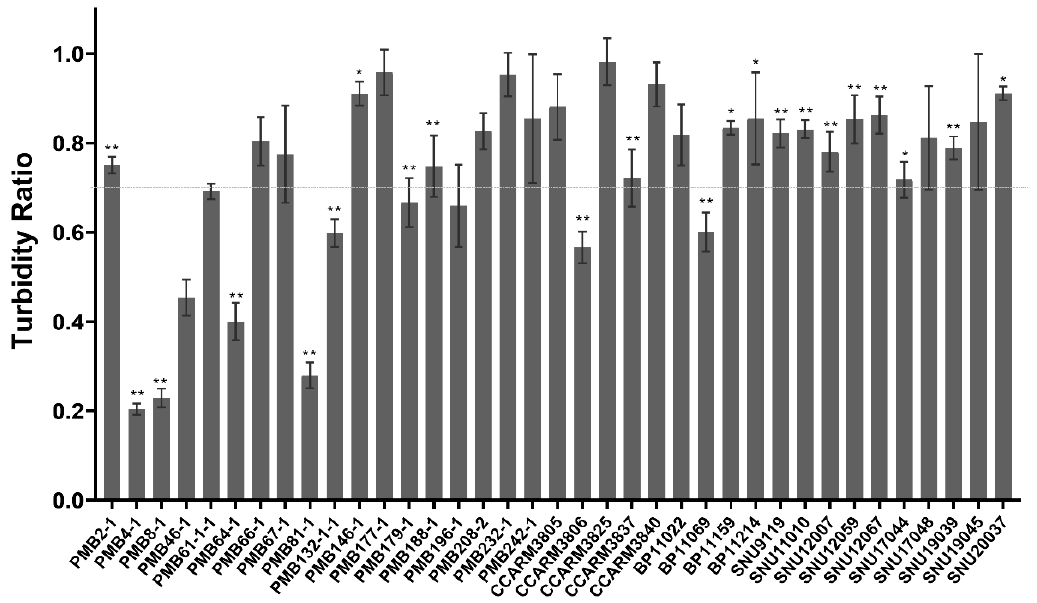
Figure 3. Different susceptibility of S. aureus strains to ALS2. After 6 h incubation of bacteria and ALS2, the turbidity ratio (TR) for each strain was determined by calculating the OD 600 value ratio of ALS2-treated to untreated samples. All experiments were performed in triplicate samples and independent experiments were triplicated for PMB2-1, PMB4-1, PMB8-1, PMB64-1, PMB67-1, PMB179-1, and CCARM3806, and duplicated for PMB66-1, PMB196-1, CCARM3837, CCARM3840, and BP11069. Single experiment was performed for other strains. The mean ± standard deviation of TR values is presented. In total, 37 strains from bovine mastitis (18 PMB strains), human infection (5 CCARM strains), and chicken infection (14 BP/SNU strains) were compared. The broken line represents the reference TR (0.7). The significance of the OD values of ALS2 treated and untreated strain was analyzed by t -test. ( n = 3, ** p < 0.01, * p < 0.05). Table 1. S. aureus strains used in the study and their susceptibility to ALS2.